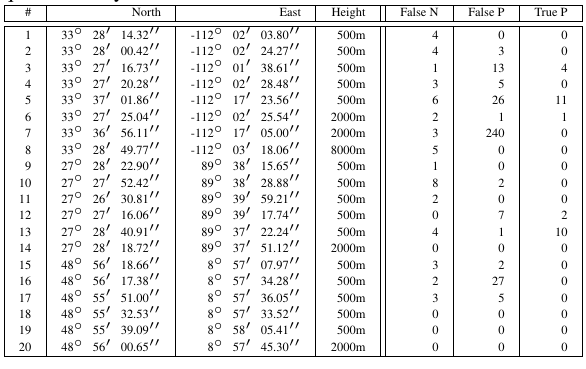
Table 1: Remotely sensed imagery dataset on which the proposed method is evaluated. In the right three columns the results are quantitatively listed. #